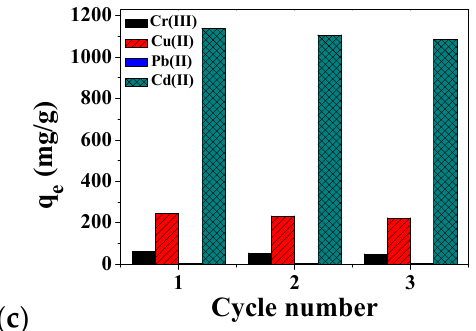
Figure 6. SEM images of Fe 3 O 4 @Me 6 TREN NPs after ( a ) adsorption and ( b ) desorption of heavy metal ions, respectively; ( c ) adsorption capacity of NPs after recycling three times.